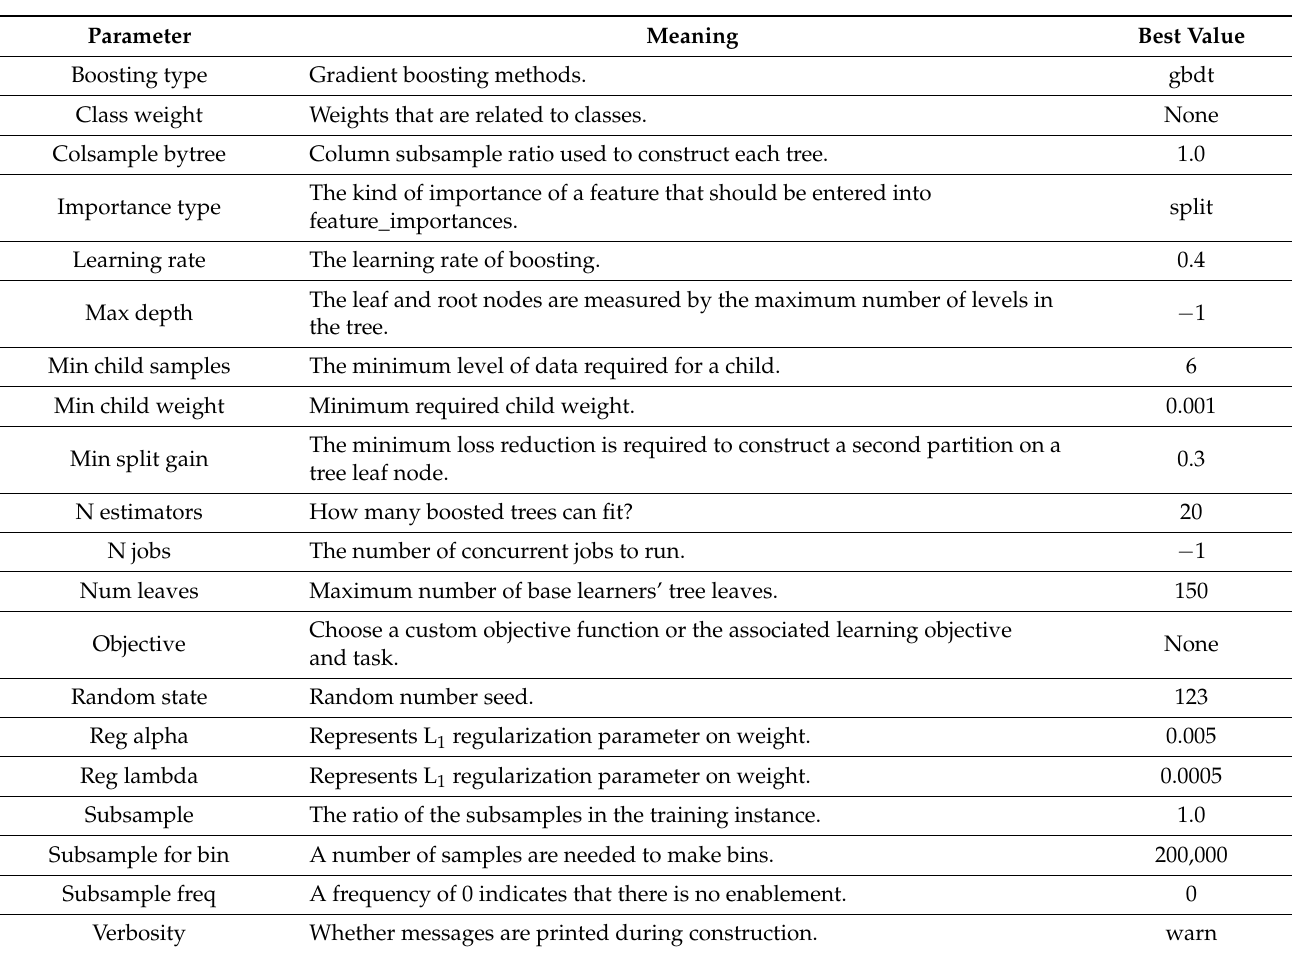
Table 5. Tuned parameters for LightGBM.